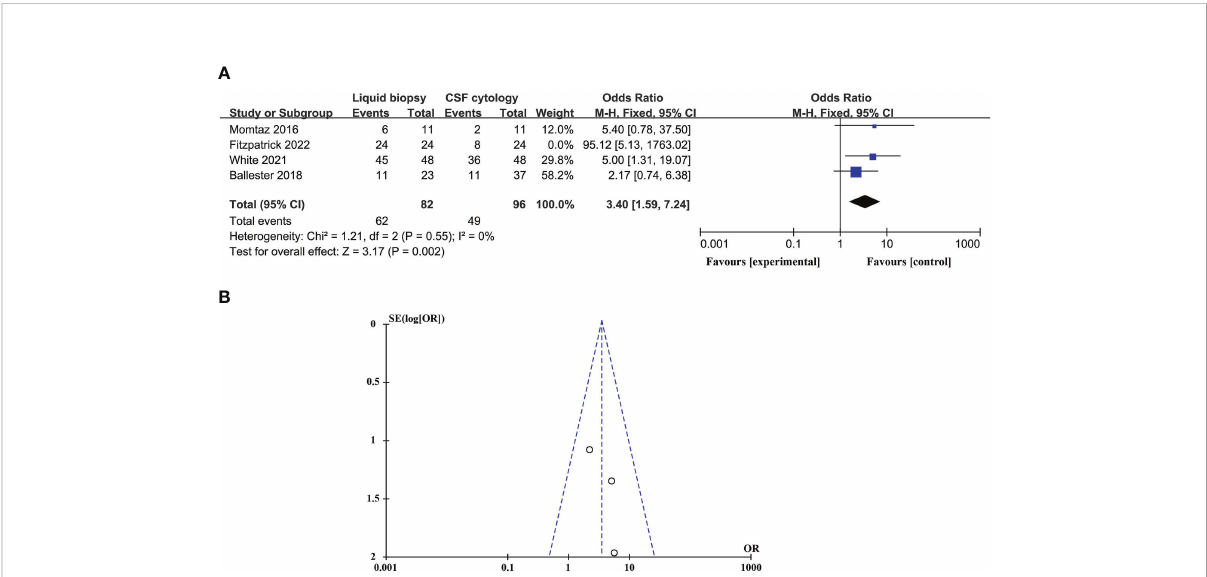
FIGURE 6 A Sensitivity analysis and publication bias. (A) . Forest plot of diagnostic advantages of CSF liquid biopsy techniques versus CSF cytology in LM after removal of heterogeneous cohorts by sensitivity analysis. (B) . Funnel plot of diagnostic advantages of CSF liquid biopsy techniques versus CSF cytology in LM after removal of heterogeneous cohorts by sensitivity analysis.